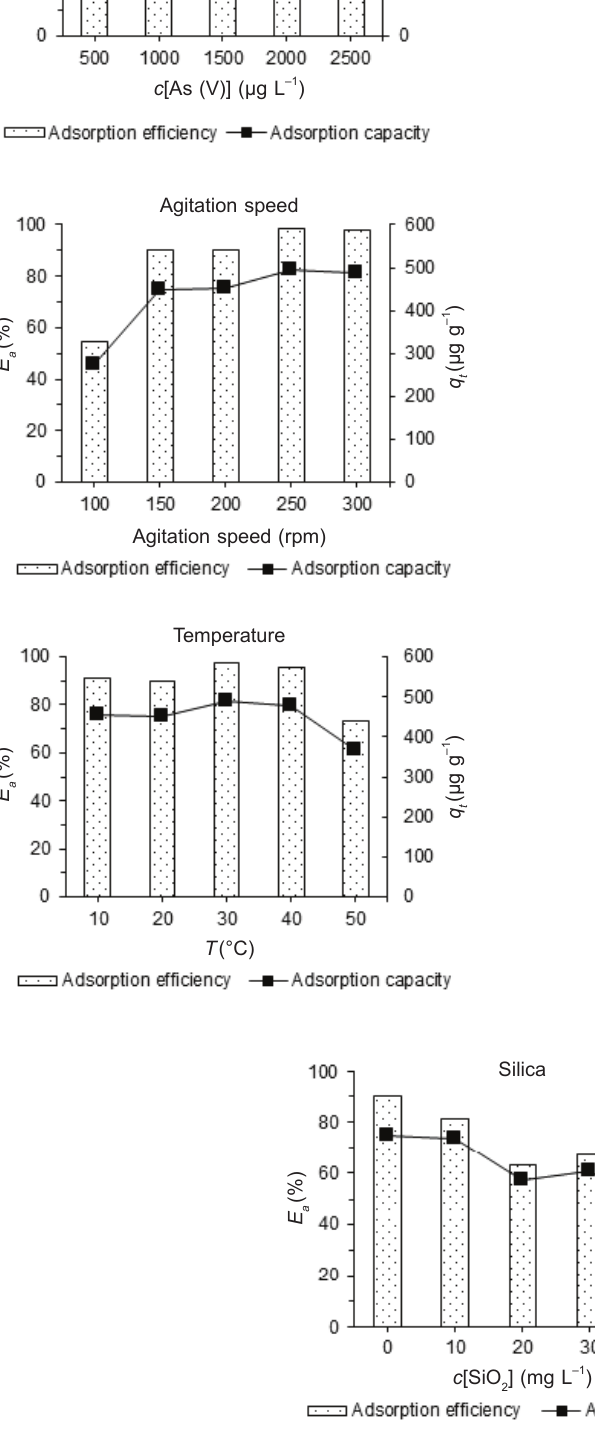
Fig. 5 – Impact of different operating conditions on As(V) adsorption by